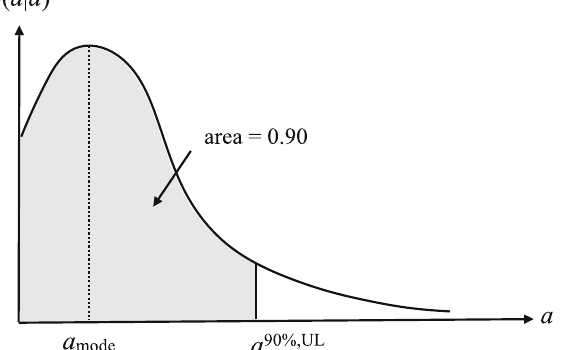
Fig. 9 Bayesian 90% credible upper limit for the parameter